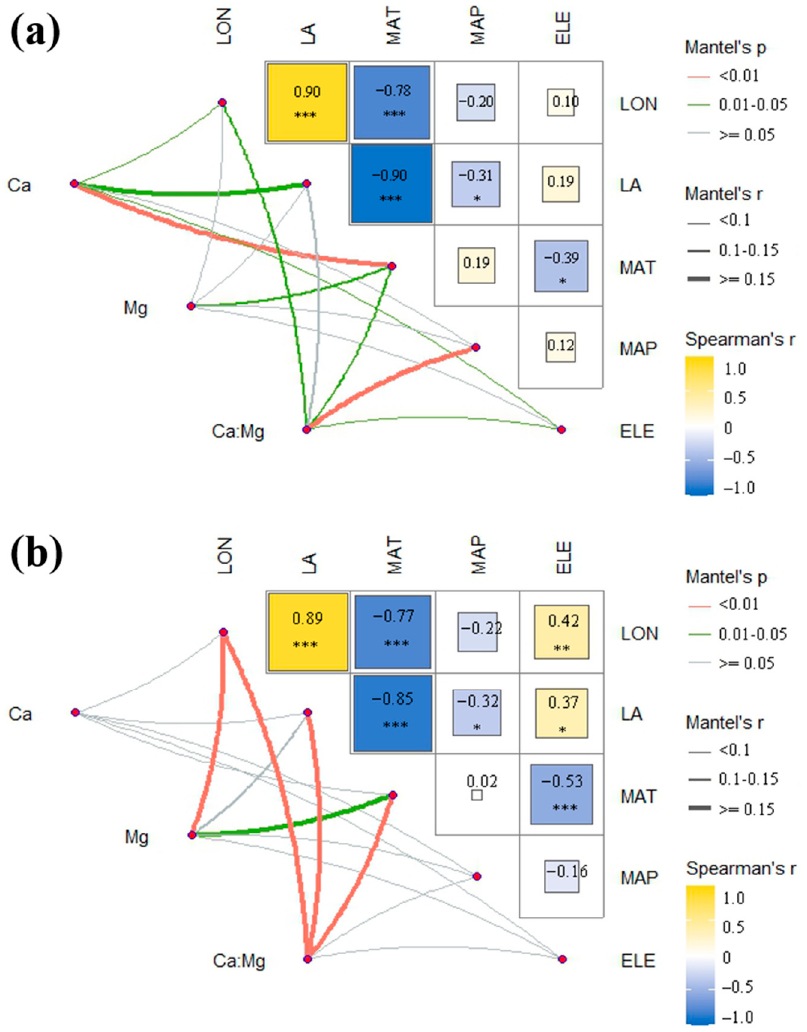
Figure 2. Correlation with environmental factors of two species. ( a ) P. massoniana ; ( b ) P. hwangshanensis . Pairwise comparisons of environmental factors are shown with a color gradient denoting Spearman’s correlation coefficients. * p < 0.05, ** p < 0.01, *** p < 0.001. The different colors of lines represent the significance between traits and environmental factors. The correlation coefficients between traits and environmental factors are expressed by lines of different thickness.